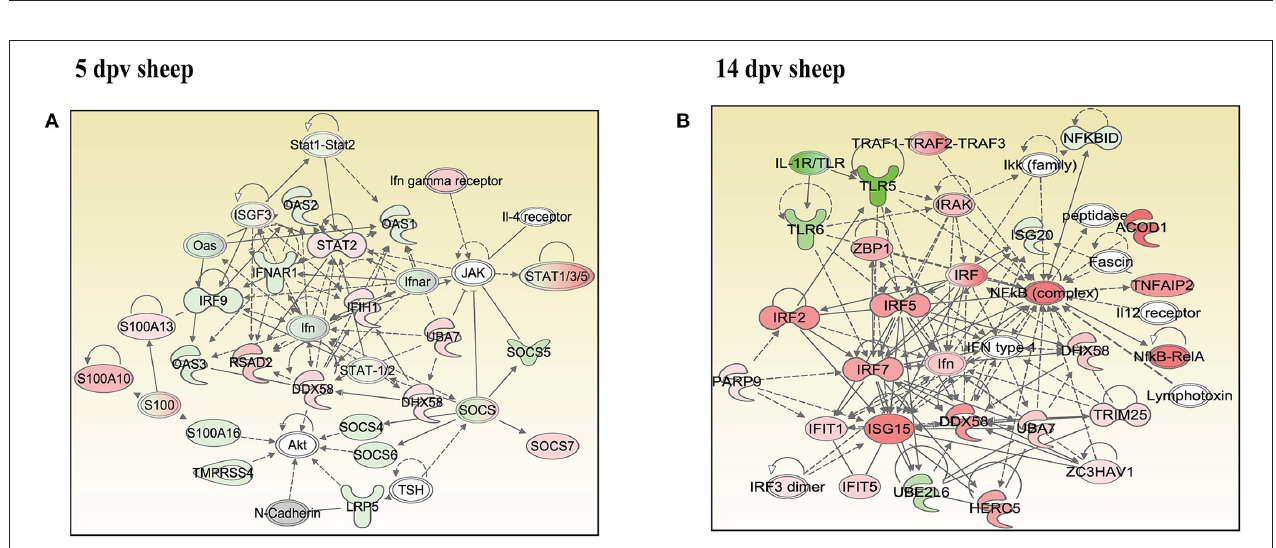
FIGURE 5 | Network generated in Ingenuity Pathway Analysis tool of “infectious diseases, antimicrobial response, and inflammatory response” of differentially expressed proteins (DEPs) in vaccinated goats at (A) 5 days post-vaccination (dpv) and (B) 14 dpv. Proteins that were upregulated are shown in red, and those that were downregulated are shown in green. Proteins in white were not significantly dysregulated. Symbol shape indicates gene function.